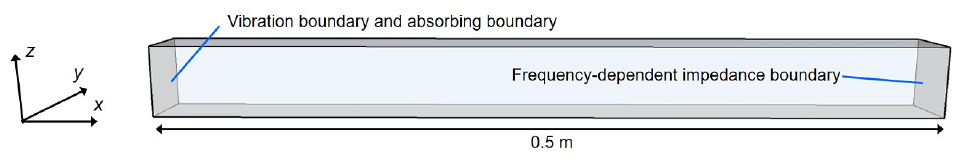
Figure 2. Impedance tube model with a frequency-dependent impedance boundary.